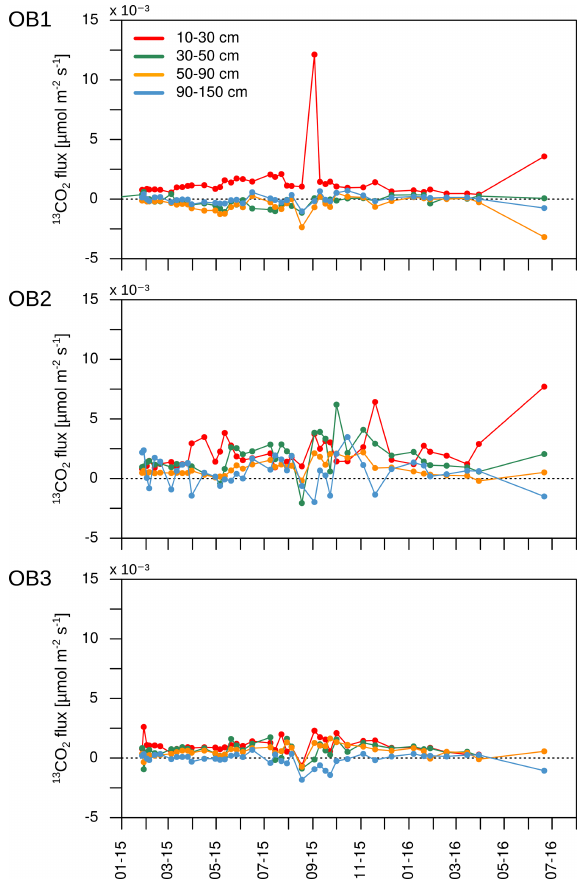
Figure 10. 13 CO 2 fluxes for each observatory. Negative fluxes rep- resent the diffusion of 13 CO 2 from the soil layer above.